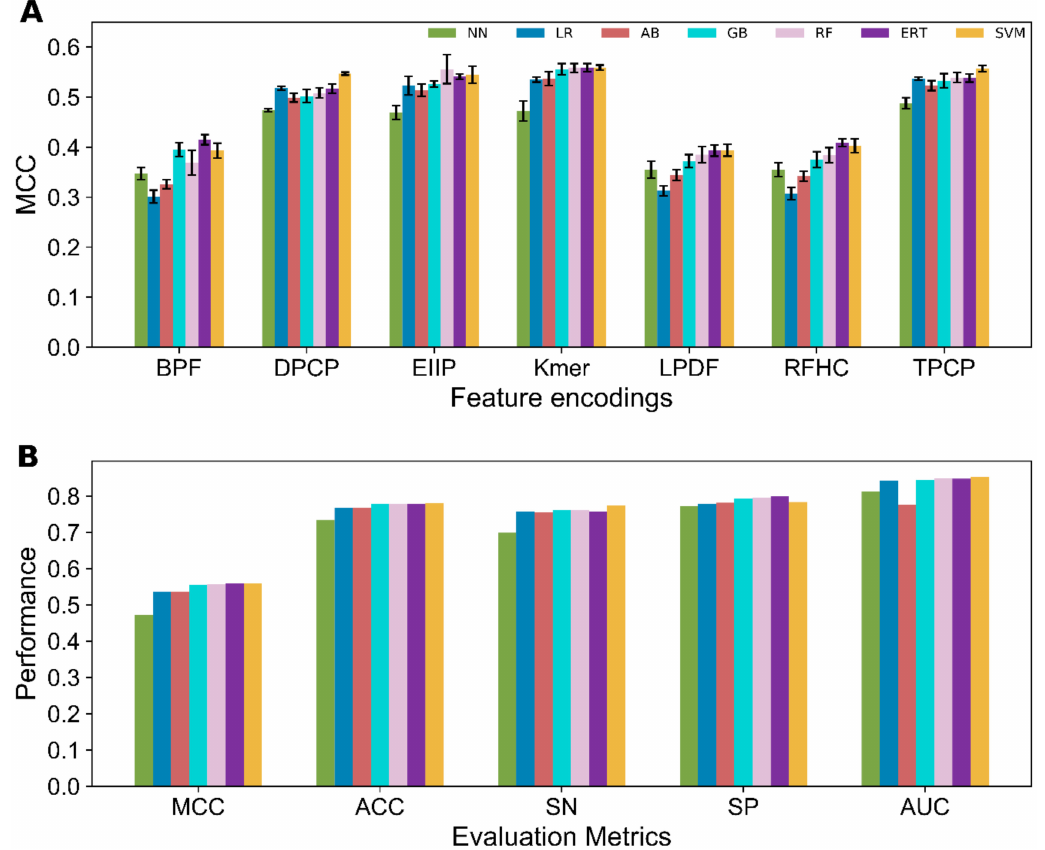
Figure 3. ( A ) Performances of seven classifiers with respect to seven feature encodings in terms of MCC. The best performance achieved by each classifier from seven encodings is shown in ( B